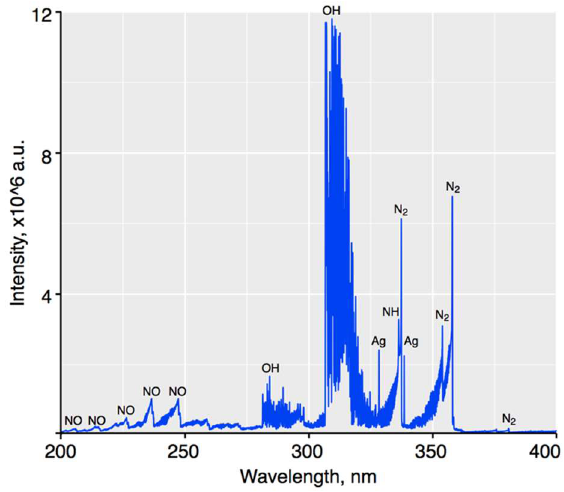
Figure 6. The optical emission spectrometry (OES) spectrum of pulse-modulated radio-frequency atmospheric-pressure glow discharge (pm-rf-APGD) generated under optimal operating